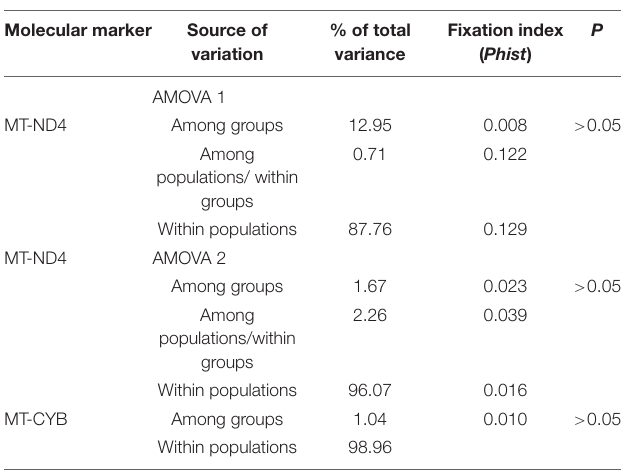
TABLE 2 | Results of the Analysis of Molecular Variance (AMOVA) of S. brasiliensis from Brazil, Venezuela, and Trinidad and Tobago. Molecular marker